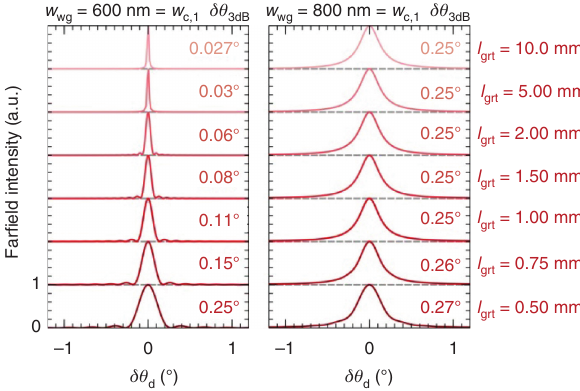
Figure 6: Predicted far-field intensities for fabricated SWGAs with varied w and l according to the measured α at the 1.55 μ m wg grt Figure 5: Measurement results for fabricated SWGAs. (A) Measured excess losses (ELs) for fabricated SWGAs with the tunable laser, whereas the collected side-wall emis- = 600 nm and varied l w at the 1.55 μ m wavelength. The red wg grt sion was detected at the output ports dashed line shows the linear fitting. The diffraction strength was measured to be α ≈ 3.3 × 10 −3 dB/ μ m. (B) Measured α for fabricated the power meter, as shown in Figure 4A. Figure 5D shows SWGAs with varied w at the 1.55 μ m wavelength. The qBIC can be o ports for fabricated the measured transmittances at the ′ wg 1 i ≈ 600 nm. (C) Measured α for fabricated SWGAs with found at w = 600 nm and w = 800 nm. For fabri- wg SWGAs with w = 600 nm at different wavelengths. The error bars refer to the wg wg w wg = 600 nm = w cated SWGA with w , the side-wall emis- standard errors of the linear fittings. The gray dashed lines show the wg c,1 sion is both weak and uniform, indicating the diffraction o ports for simulation results. (D) Measured transmittances at the ′ i = 600 nm = w = 800 nm > w fabricated SWGAs with w and w . depression effect induced by the quasi-BIC. In contrast, wg c,1 wg c,1 The gray dashed line shows the detection limit (DL). The red and = 800 nm > w for fabricated SWGA with w , the side-wall wg c,1 blue dashed lines show the linear fittings. emission decays rapidly over a short distance, indicating the significant diffraction strength. To further evaluate the performance of fabricated SWGAs, we also predict the side-wall emission over a 50 μ m propagation length. The divergence angles δ θ spacing between the adjacent shallow-ridge taper is 200 by calculating the far-field inten- 3 dB μ m. The TE sities according to the measured α , as shown in Figure 6. mode was launched at the i input port using 0 0